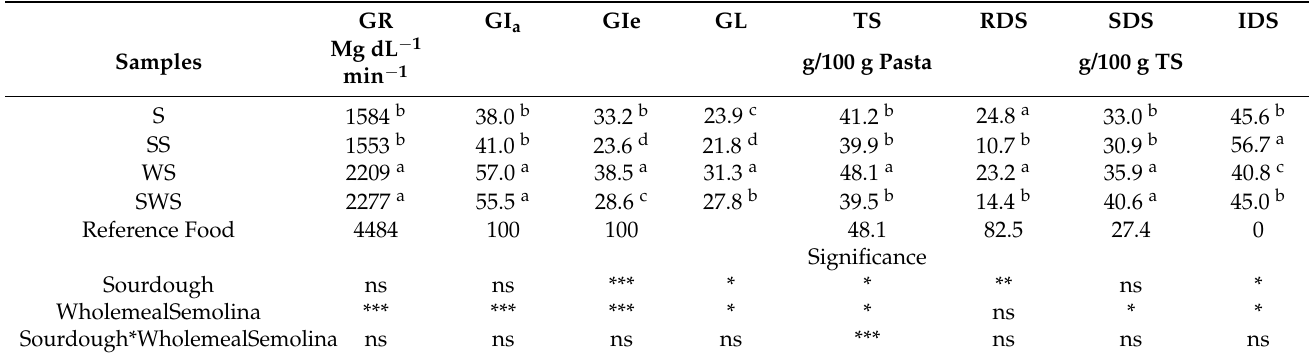
Table 2. Results of in vivo digestion and in vitro starch hydrolysis of